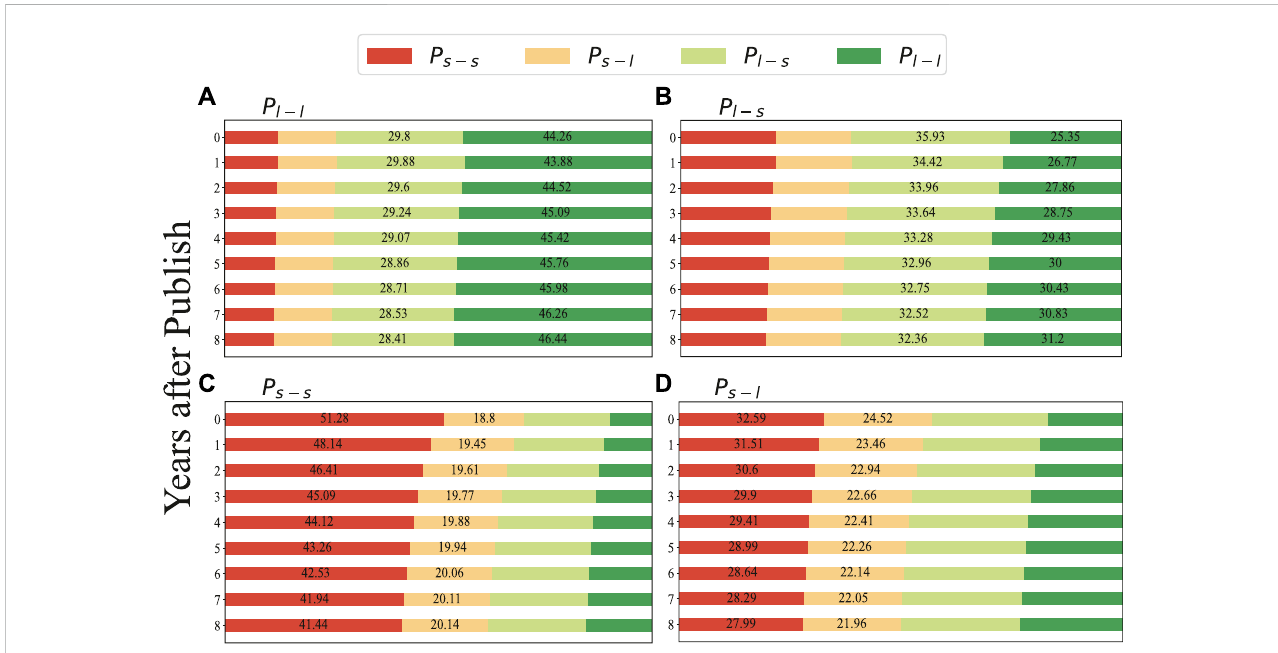
FIGURE 5 The citations attribution for different interdisciplinary types. We select the papers published after 2008, and the vertical axis represent the years after publish.Thetargetdisciplinesareconsideredasthelargediscipline P l − l (darkgreencolumn)acrosssmalldiscipline P l − s (lightgreencolumn),andthesmall P s − s